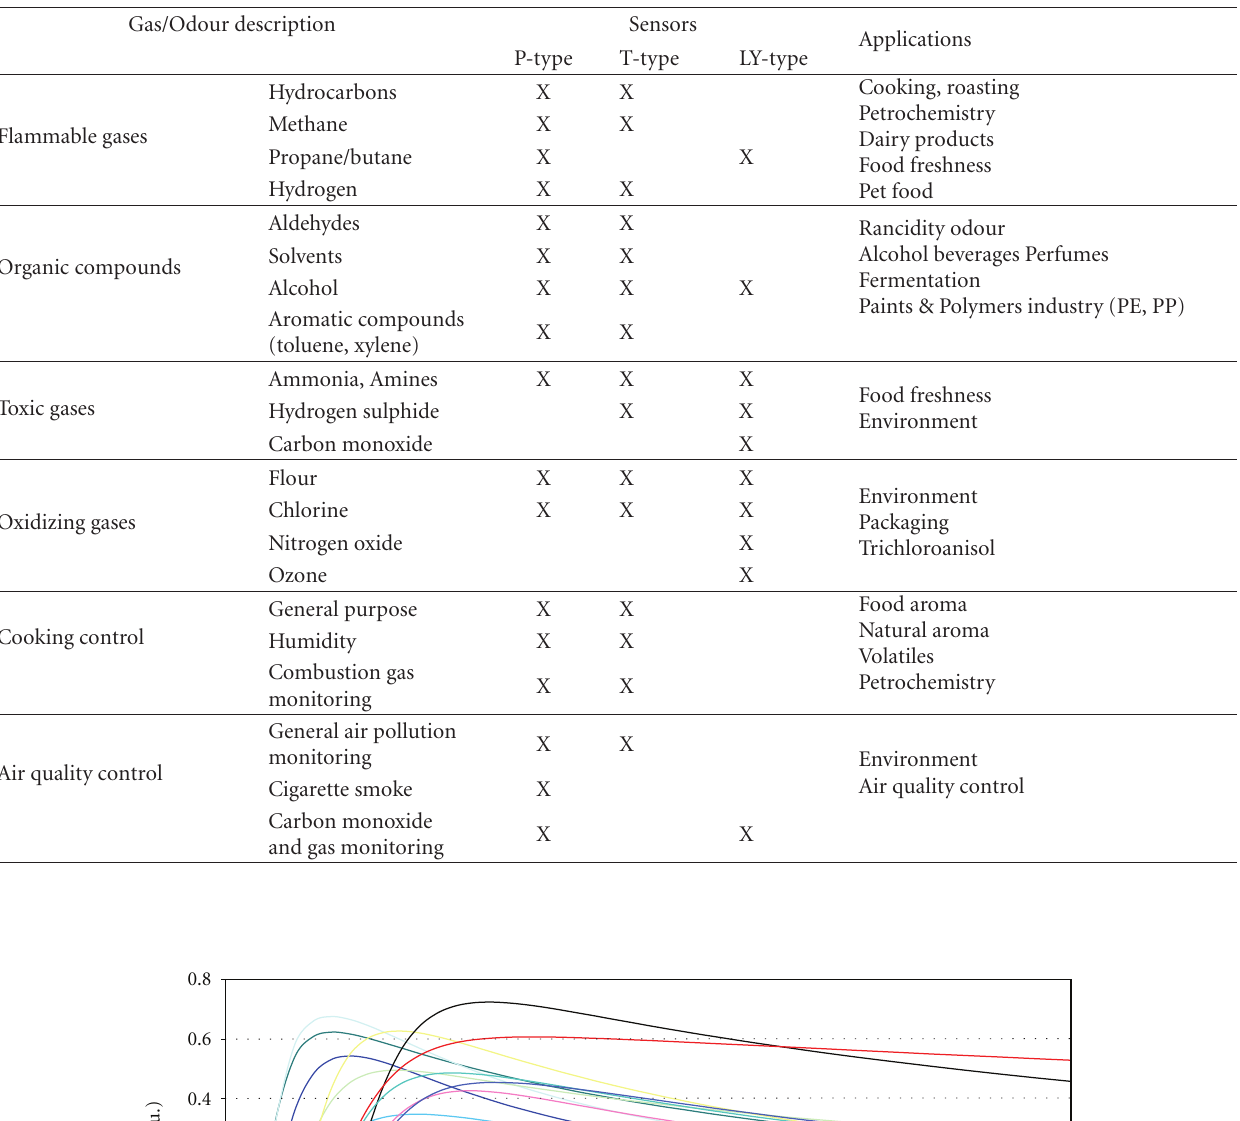
Table 1: Sensors selectivity for di ff erent gases (Reference Manual, Alpha MOS, France).